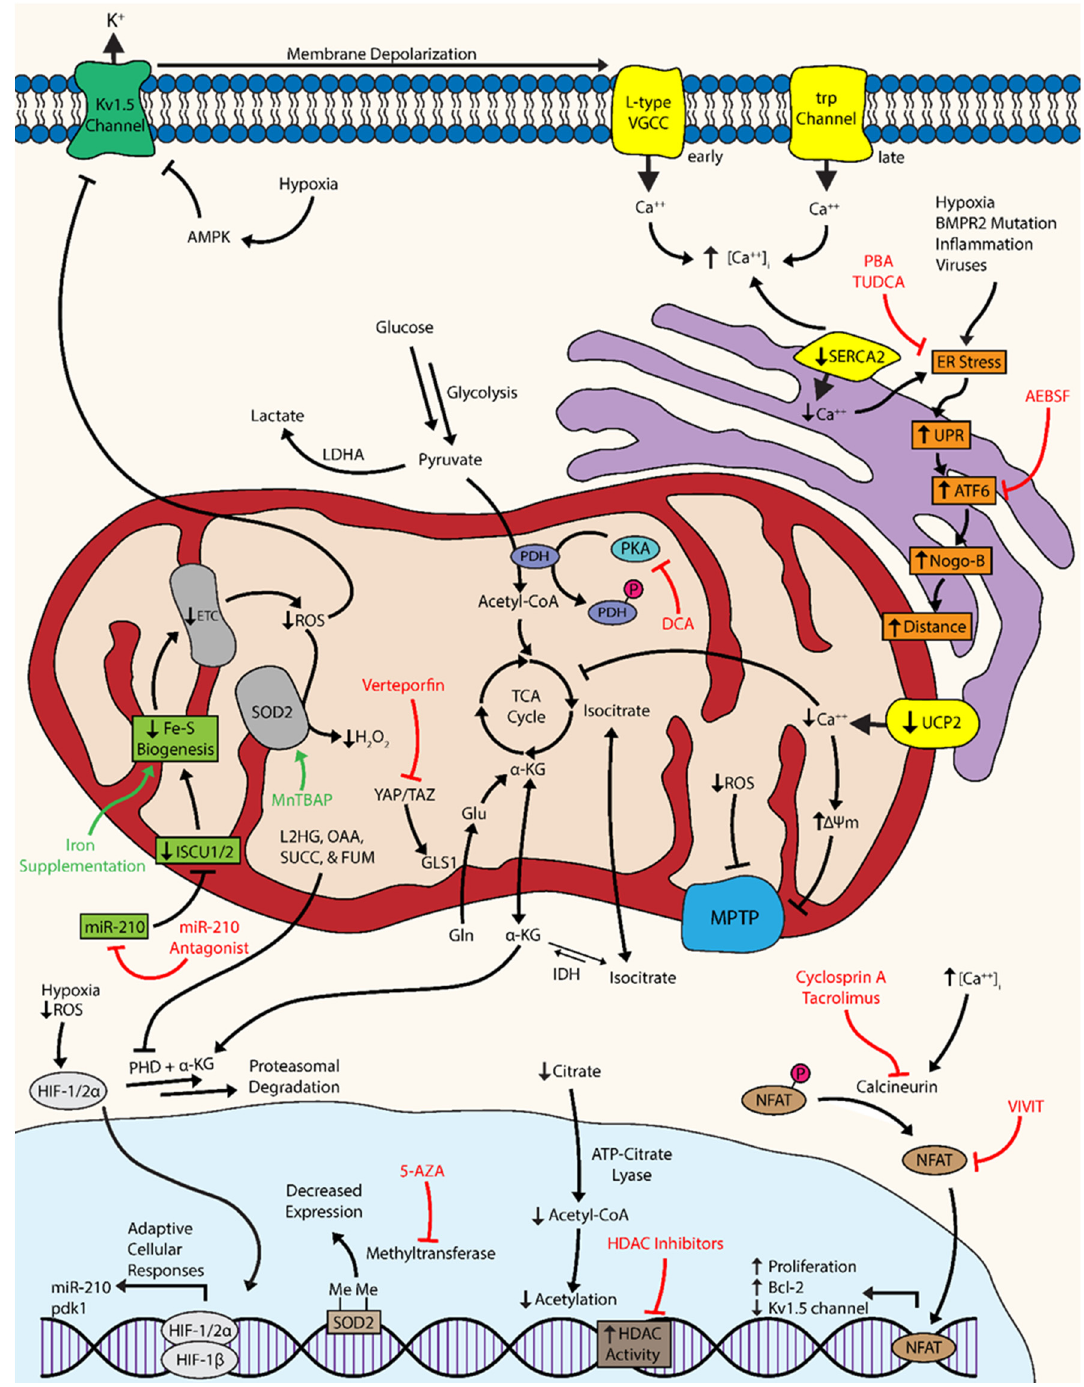
Figure 1. A Metabolic Theory of Pulmonary Hypertension. The activation of hypoxia ‐ inducible factor ‐ 1/2 α (HIF ‐ 1/2 α ) results in its nuclear translocation and binding with HIF ‐ 1 β . The heterodimeric transcription factor binds to a hypoxic response element, where genes involved in adaptive cellular responses are upregulated (i.e., pdk1 and micro ‐ RNA 210 [miR ‐ 210]). Upregulation of pyruvate dehydrogenase kinase (PDK) results in the phosphorylation and inhibition of pyruvate dehydrogenase (PDH), limiting the flow of acetyl ‐ CoA into the tricarboxylic acid (TCA) cycle for glucose oxidation. Instead, pyruvate is shunted via lactose dehydrogenase A (LDHA) into lactate for anaerobic respiration. HIF ‐ mediated upregulation of miR ‐ 210 negatively regulations expression of iron ‐ sulfur cluster assembly proteins 1 and 2 (ISCU1/2), causing a decrease in iron ‐ sulfur biogenesis. The decrease in iron ‐ sulfur cluster biogenesis attenuates mitochondrial respiration in the electron transport chain (ETC) and reactive oxygen species (ROS) generation. A decrease in ROS coupled with